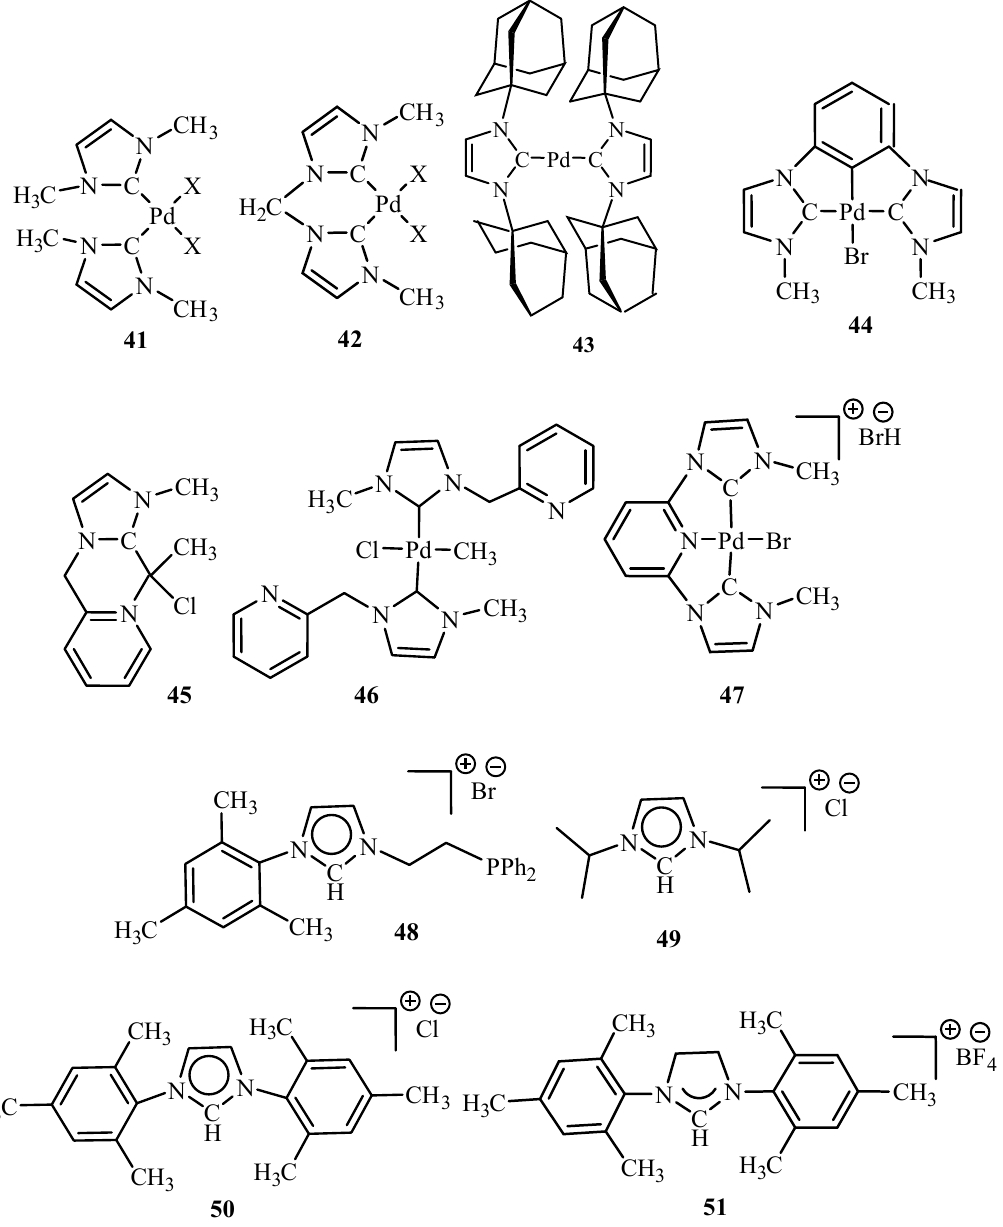
Figure 7. N-heterocyclic carbene ligands and metal complexes reviewed by Herrmann Figure 7. N ‐ heterocyclic carbene ligands and metal complexes reviewed by Herrmann [18].